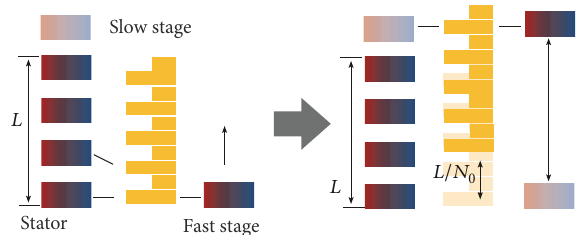
Figure 1: Magnetic linear impedance coupler concept.